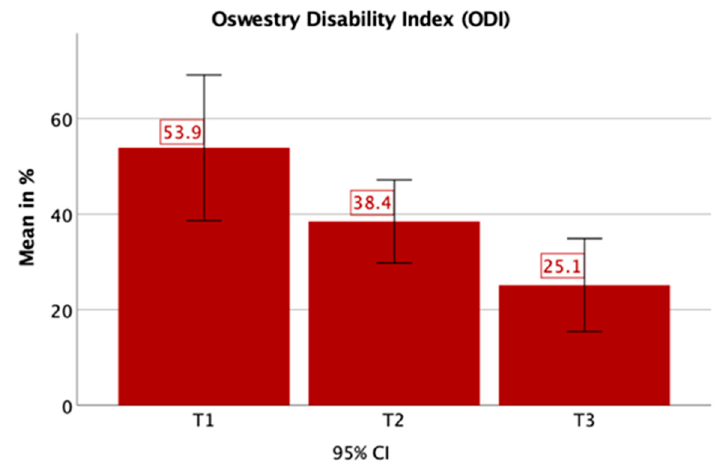
Figure 5. The Oswestry Disability Index (ODI) showed severe disablitiy at T1, and moderate disability at T2 and T3. There was a significant improvement from T1 to T3.